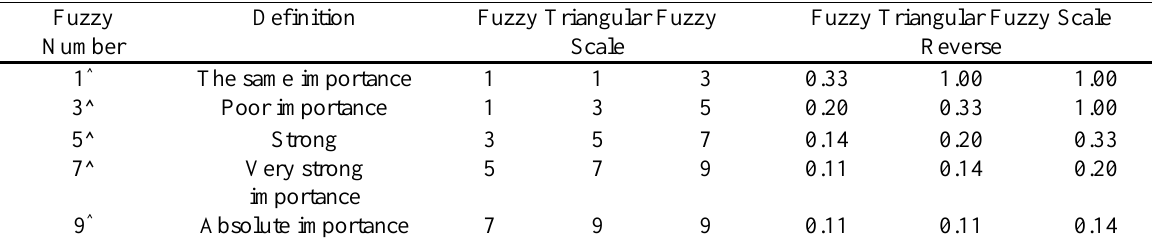
Table 2. The ratio scale